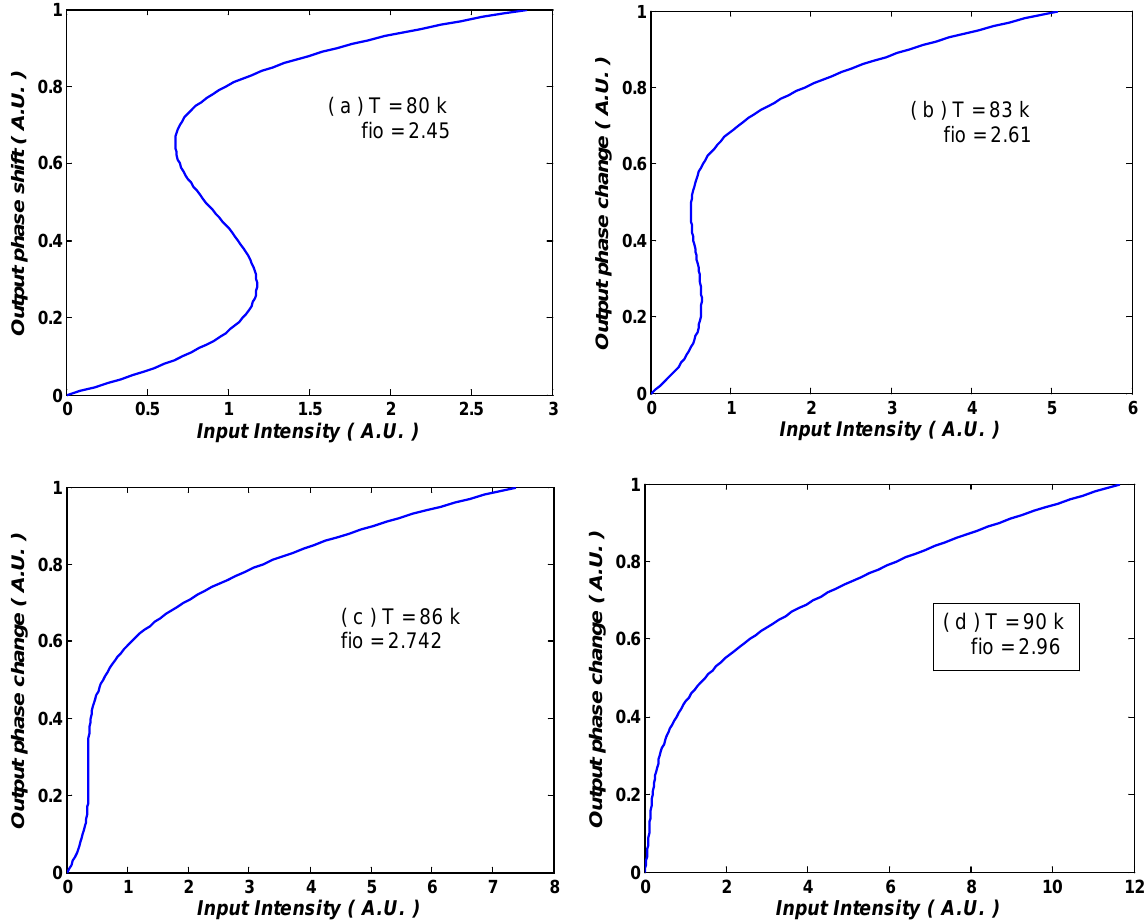
Fig.3: Input / output intensity characteristic for different etalon temperature: (a) large loop, (b) small loop, (c) critical switching, and (d) optical nonlinear nonlinearity characteristic